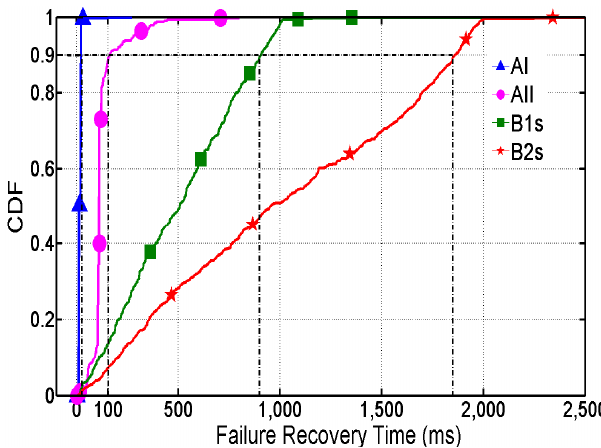
Figure 6. Failure Recovery Time of CDF.